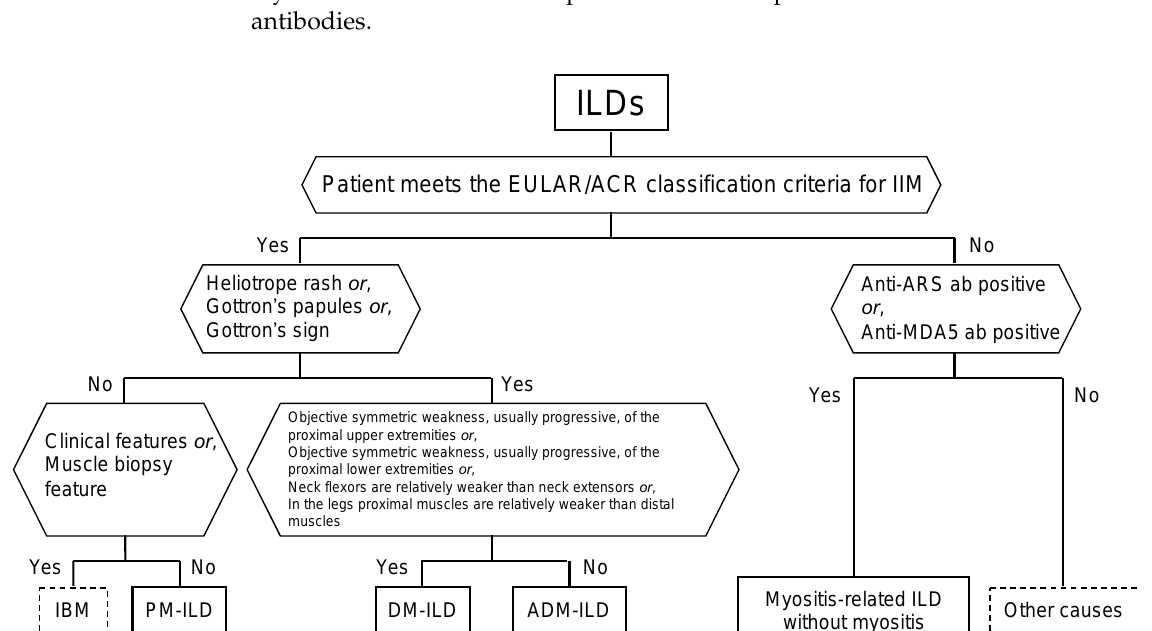
Figure 3. Classification tree for subgroups of adult myositis-related interstitial lung disease (ILD). A patient must first meet the EULAR/ACR classification criteria for inflammatory myopathies (IIM). The patient can then be sub-classified using the classification tree (modified from the figure in Reference [5]). ARS, aminoacyl-tRNA synthetase; ab, antibody; MDA5, melanoma differentiation-associated gene 5; IBM, inclusion body myositis; PM, polymyositis; DM, dermatomyositis; ADM, amyopathic dermatomyositis.